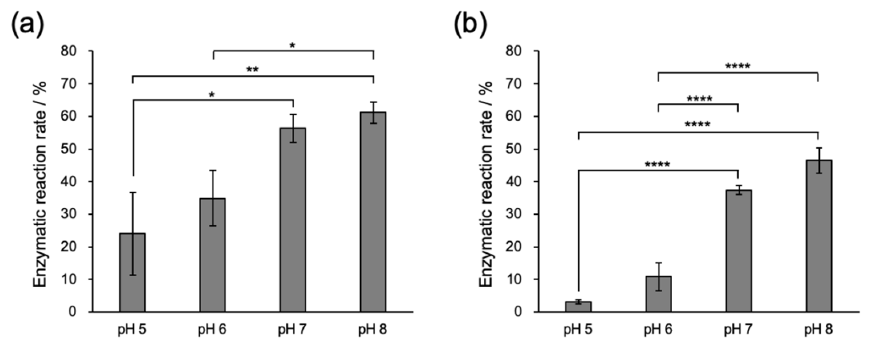
Figure 5. Microbial transglutaminase (MTG) enzymatic reaction rates of ( a ) Fmoc-L 2 QG and ( b ) Fmoc-L 3 QG in an assembled state. The enzymatic reaction was performed with Oregon green 488 cadaverine (OG) as an amine substrate. n = 3, * p < 0.05, ** p < 0.01, **** p < 0.0001.